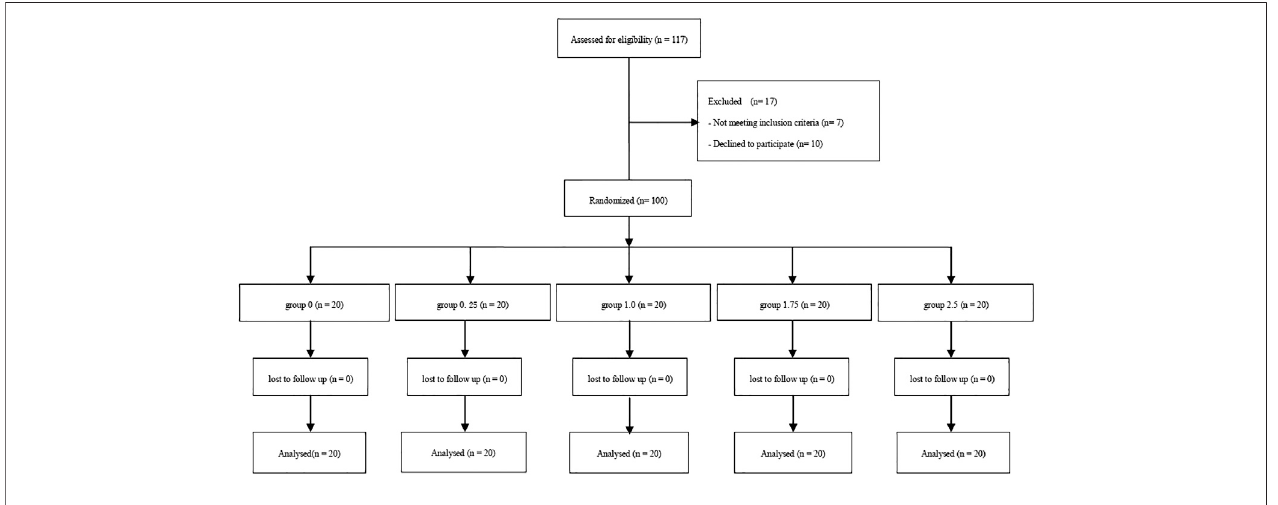
FIGURE 1 | Consort fl ow diagram.